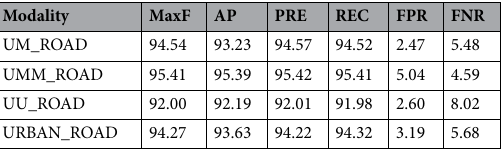
Table 2. Performance of the proposed model on KITTI (BEV) (/%).